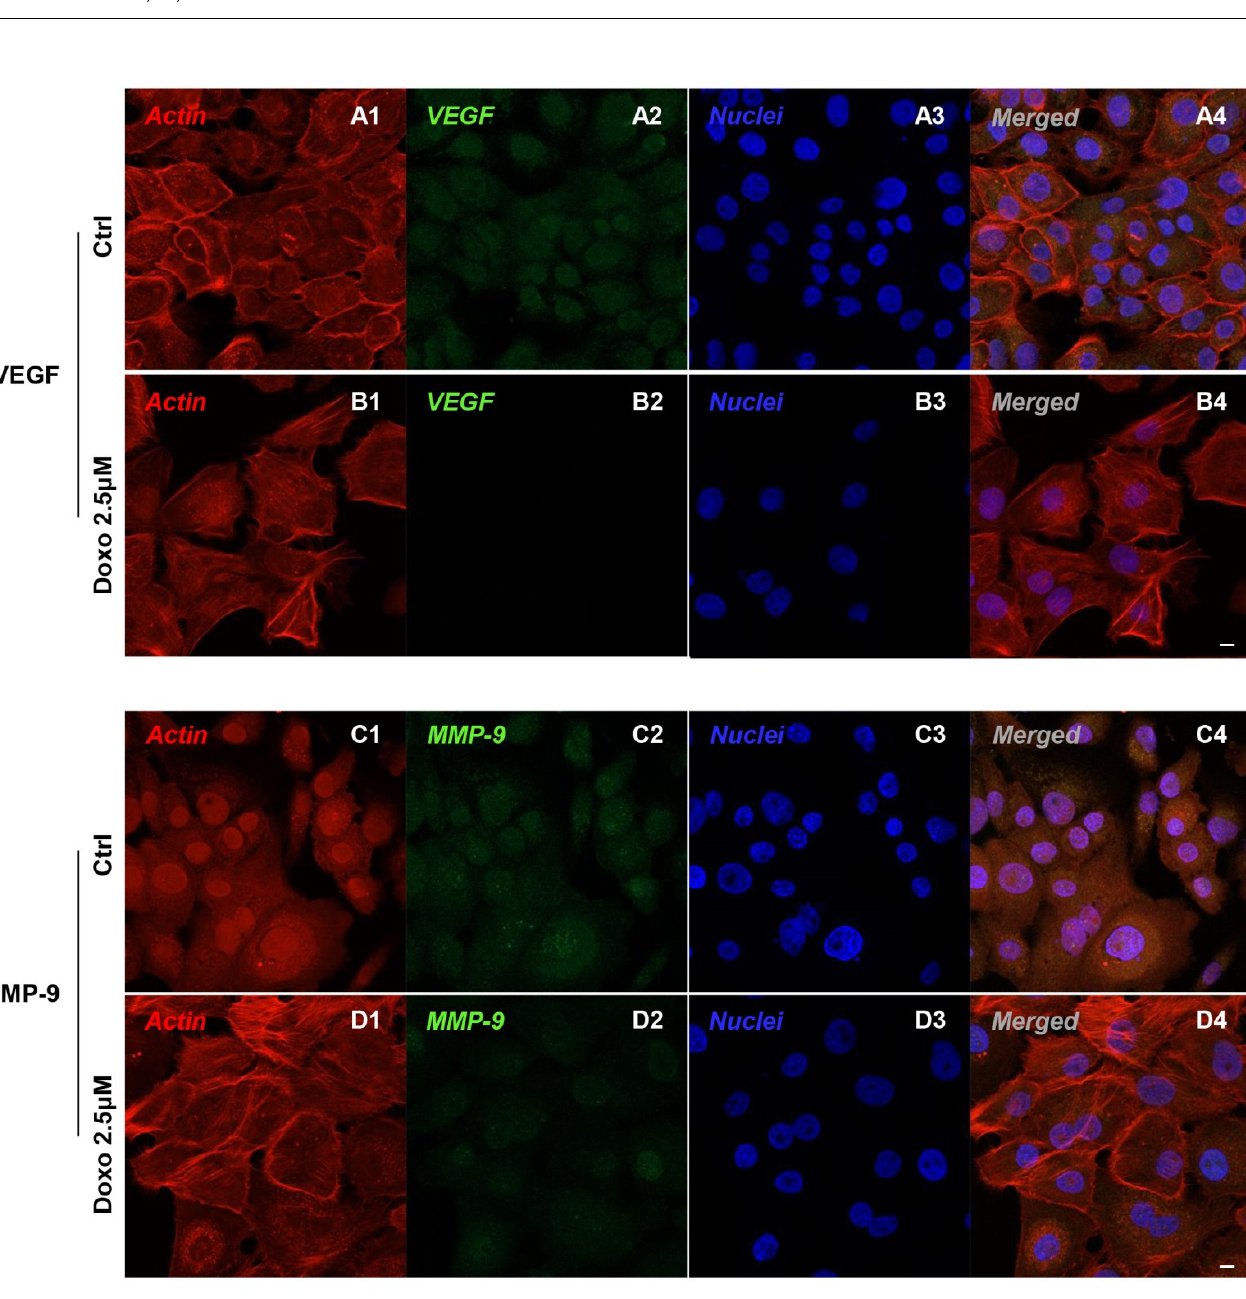
Figure 4. Confocal microscopic analysis on the expression of VEGF and MMP-9 in Cal-27 cell lines. Expression of VEGF and MMP-9 analyzed by confocal microscopy in untreated cells (CTRL) ( A1 – A4 , C1 – C4 ); expression of VEGF and MMP-9 analyzed by confocal microscopy in Cal-27 treated with Doxo 2.5 µM ( B1 – B4 , D1 – D4 ). Red fluorescence: cytoskeleton actin. Green fluorescence: VEGF, MMP-9, ERK 1/2 and pERK 1/2. Blue fluorescence: cell nuclei. Scale bar: 20 µm.